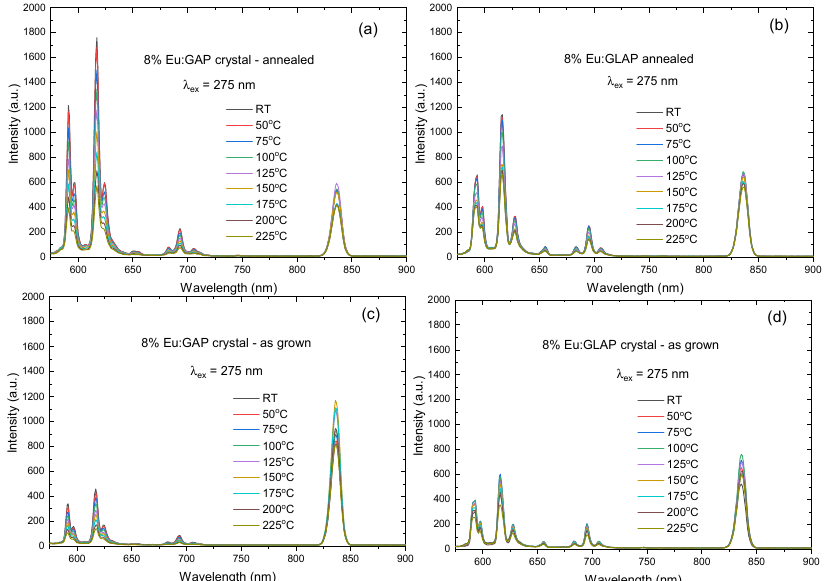
Figure 6. PL spectra of the ( a ) Eu:GAP crystal; ( b ) Eu:GLAP crystal with the post Ar (+5% H 2 ) an- nealing process; ( c ) as-grown Eu:GAP crystal and ( d ) as-grown Eu:GLAP crystal at different tem- peratures from RT to 225 °C.